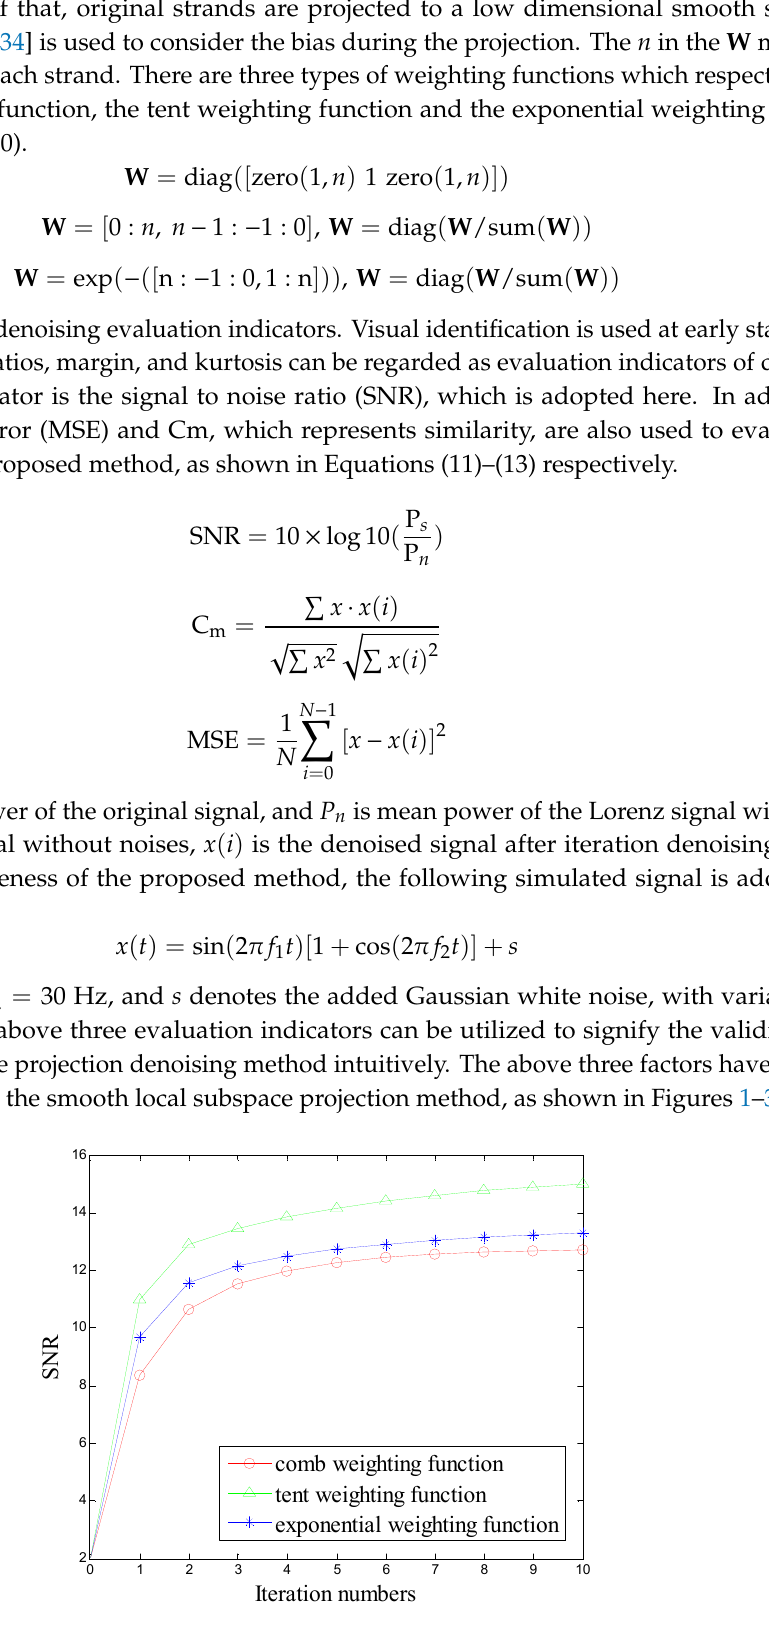
Figure 1. Signal to noise ratio (SNR) values along with